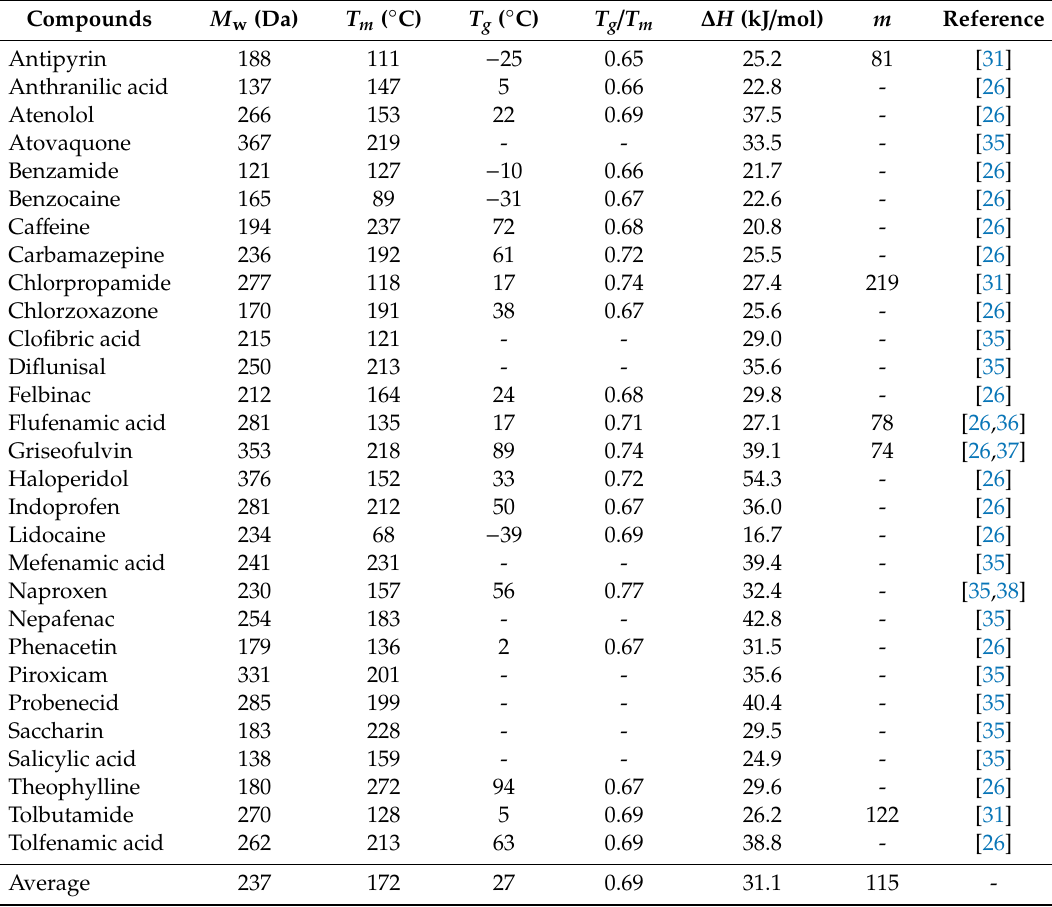
Table 2. Examples of Class 1 compounds.